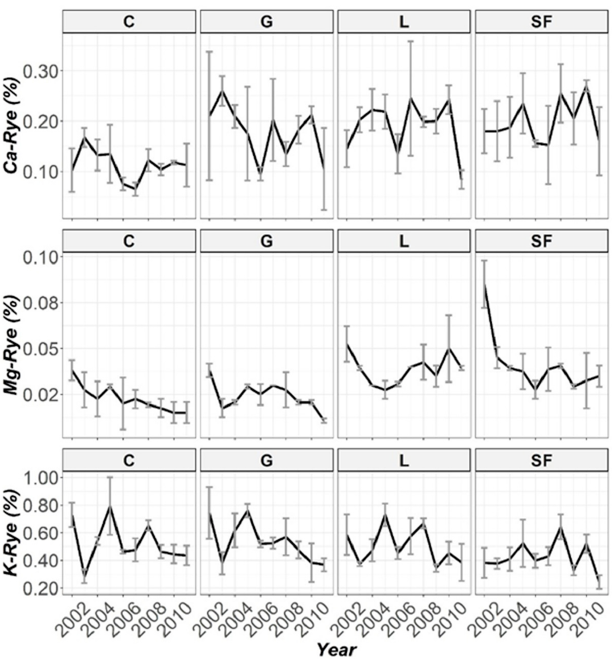
Figure 8. Temporal evolution of Ca, Mg and K levels in stem throughout the ten years of cation content in stem monitoring (2002–2011).